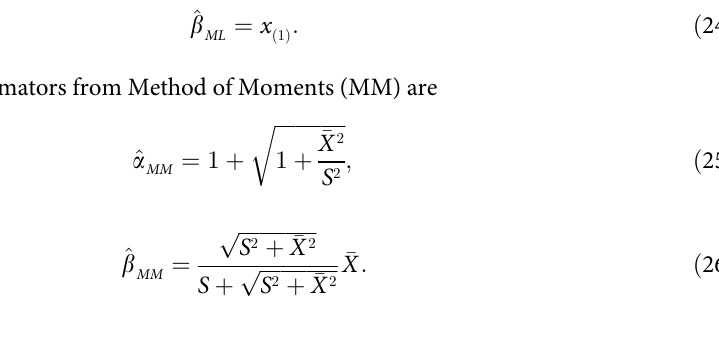
ffiffiffiffiffiffiffiffiffiffiffiffiffiffiffi p S 2 þ (cid:22) X 2